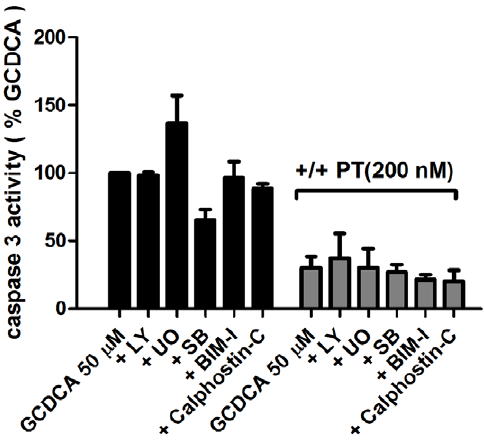
Figure 3. The protective effect of pertussis toxin (PT) is independent of the activation of specific kinases. ( a ) Caspase-3 activity in rat hepatocytes treated with 50 m mol/L of GCDCA in the presence and absence of 200 nmol/L PT and with or without the inhibitors of ERK1/2- MAPK (10 m mol/L of U0126; U0), p38 MAPK (10 m mol/L of SB 203580; SB), PI3K (50 m mol/L of LY 294002; LY), PKC